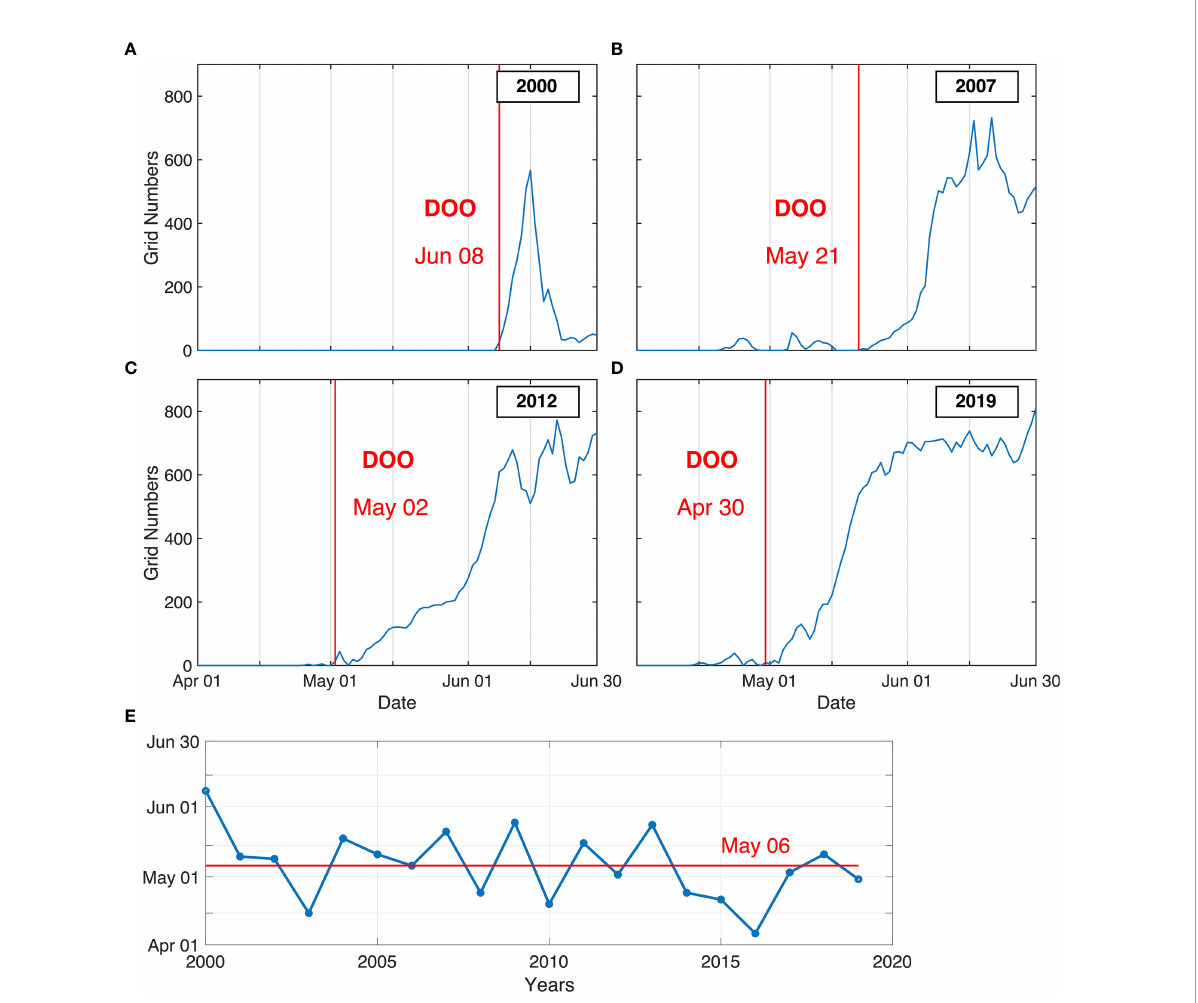
FIGURE 2 Time series of grid cell numbers with ice concentration lower than 0.8 (blue curve) starting on 1 April in (A) 2000, (B) 2007, (C) 2012, and (D) 2019. The study region is outlined by the blue box in Figure 1A. The red line in (A – D) marks the date of opening (DOO). (E) Interannual variability in DOO during the 2000 – 2019 period. The red line in (E) indicates the mean DOO (6